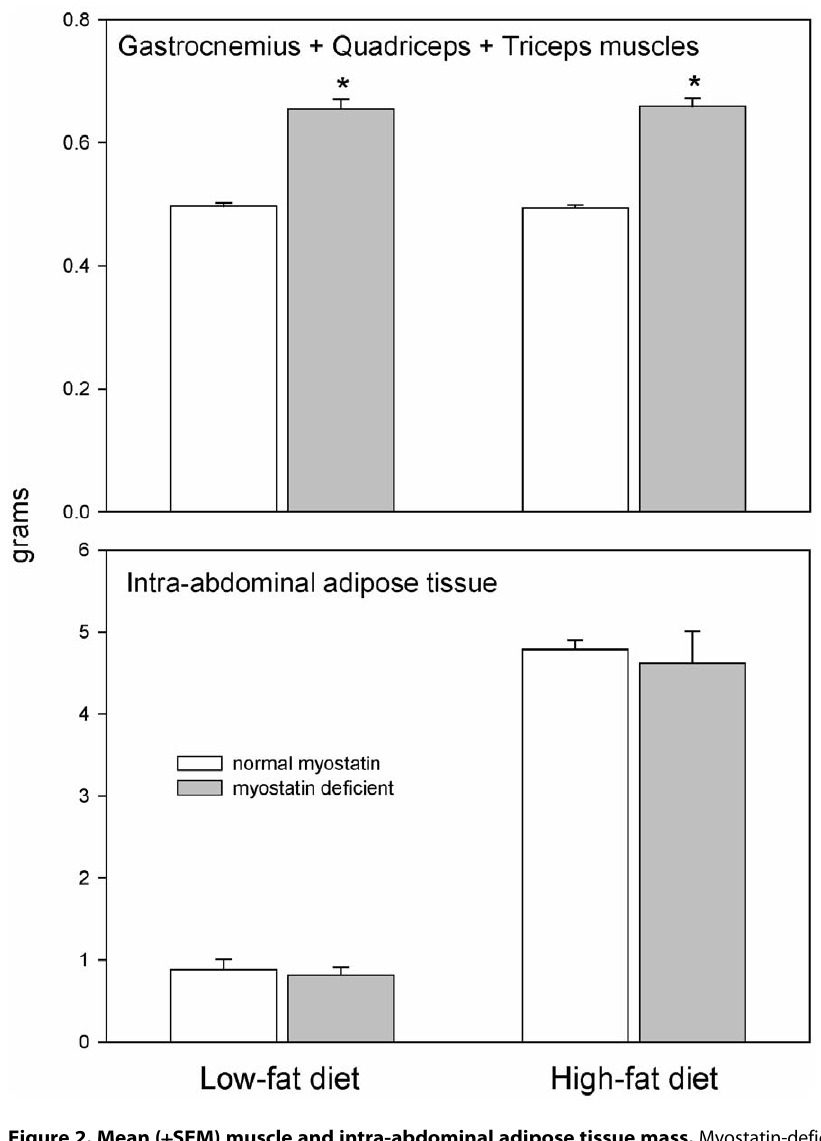
Figure 2. Mean ( + SEM) muscle and intra-abdominal adipose tissue mass. Myostatin-deficient (gray bars) and control mice (white bars) were fed a normal low-fat diet (13% of energy from fat) or were fed a high-fat diet (60% of energy from fat) for the final 22 weeks of the experiment. Each bar represents the mean and SEM of 12–15 mice. * P , 0.001 versus mice with normal myostatin levels.